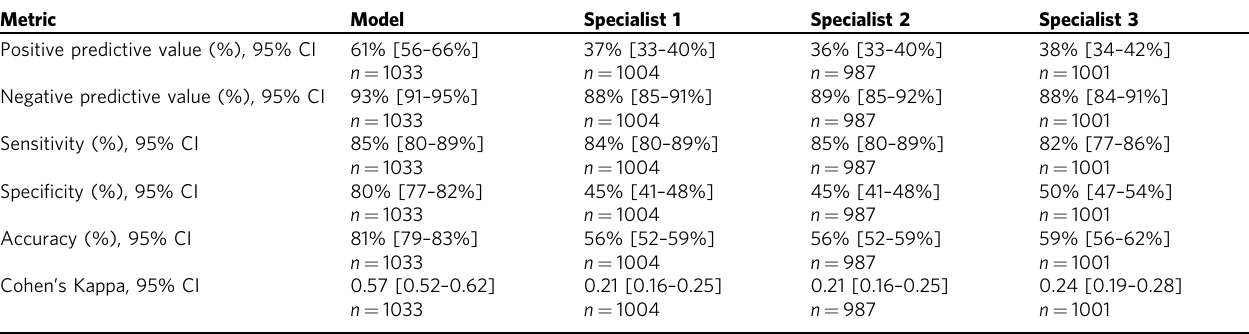
Table 2 Performance metrics of the model and retinal specialists on the primary clinical validation set.